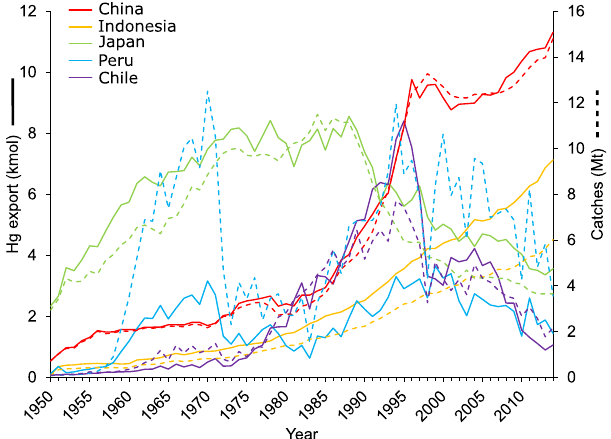
Figure 3. Temporal trends (1950 ‒ 2014) of catches (dashed lines) and Hg exported (full lines). China (red), Indonesia (orange), Japan (green), Peru (blue), and Chile (purple).